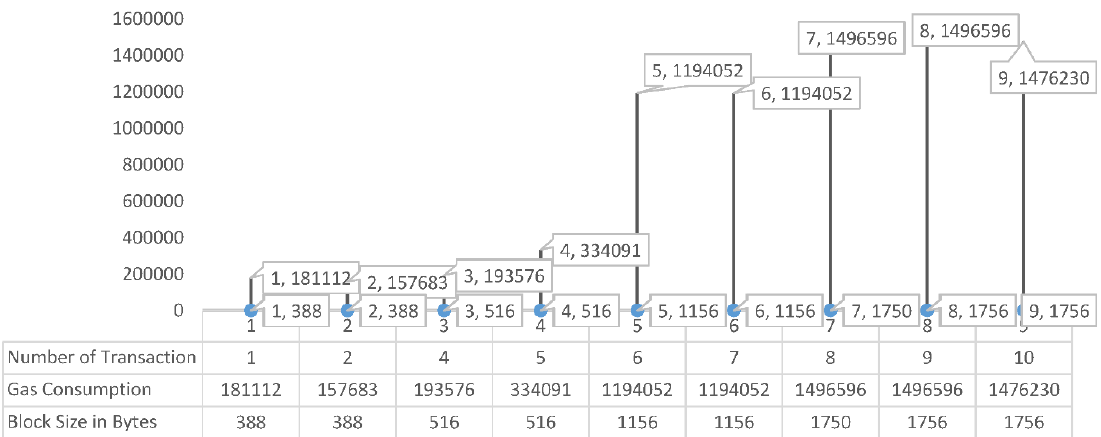
Figure 7. Utilized gas depends on the block size and the number of transactions.